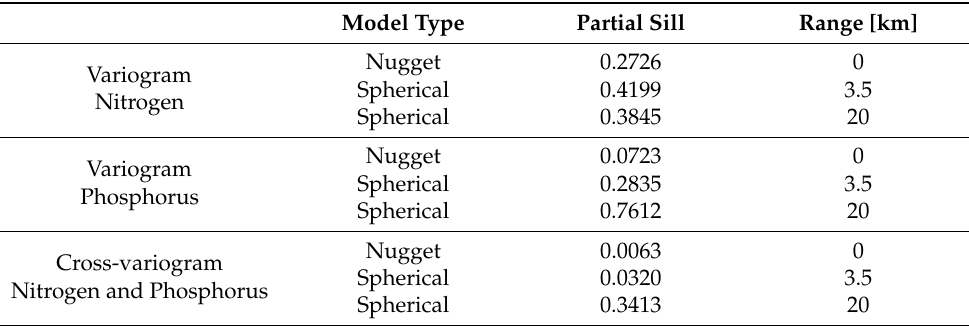
Figure 4. Experimental direct and cross-variograms (open circles) for the nutrients nitrogen and phosphorus and the fitted linear model of coregionalization (solid lines). Annotation: parameters of the fitted linear model of coregionalization can be found in Table 2. Table 2. Shapes and parameters of the linear model of coregionalization fitted to the experimental direct and cross-variograms presented in Figure 4.